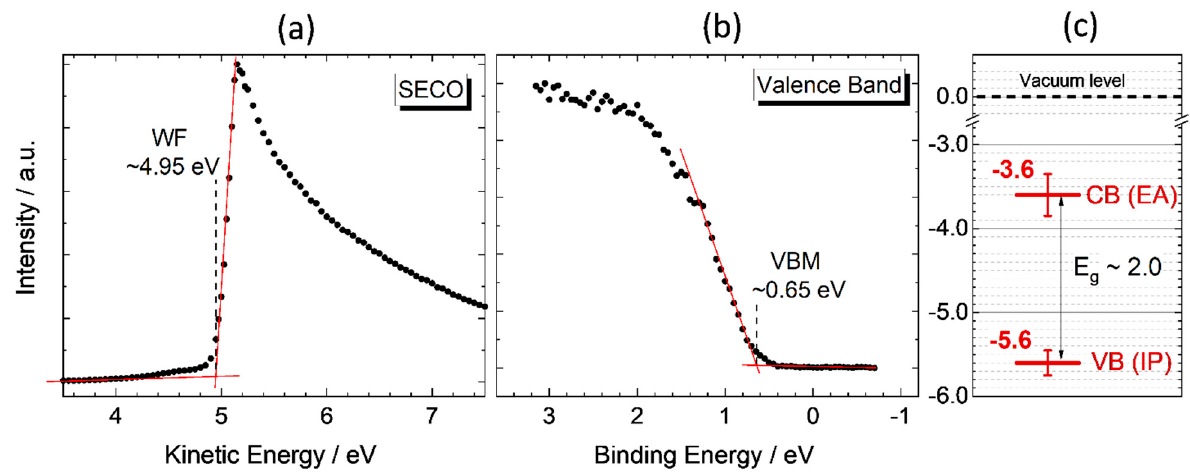
Figure 13. The secondary electron cut-off (SECO) ( a ) and valence band ( b ) X-ray-induced photoelectron spectra. Schematic representation of the valence band (VB) and conduction band (CB) energy levels relative to the vacuum level ( c ). The spectra are obtained under monochromated Al K α excitation, h ν = 1486.7 eV.